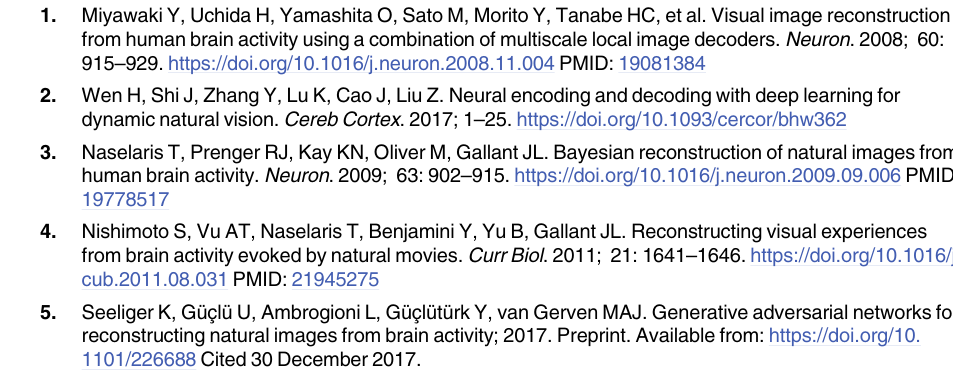
S2 Movie. Deep image reconstruction: Artificial shapes. The iterative optimization process is shown (left, presented images; right, reconstructed images). S3 Movie. Deep image reconstruction: Imagery images. The iterative optimization process is shown (left, imagined images; right, reconstructed